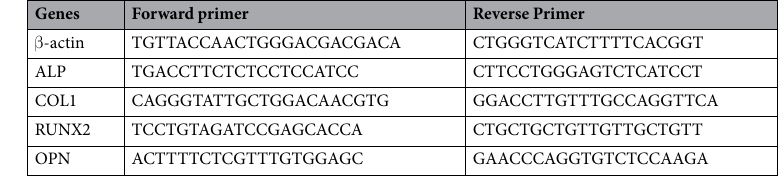
Table 2. The primer sequences of